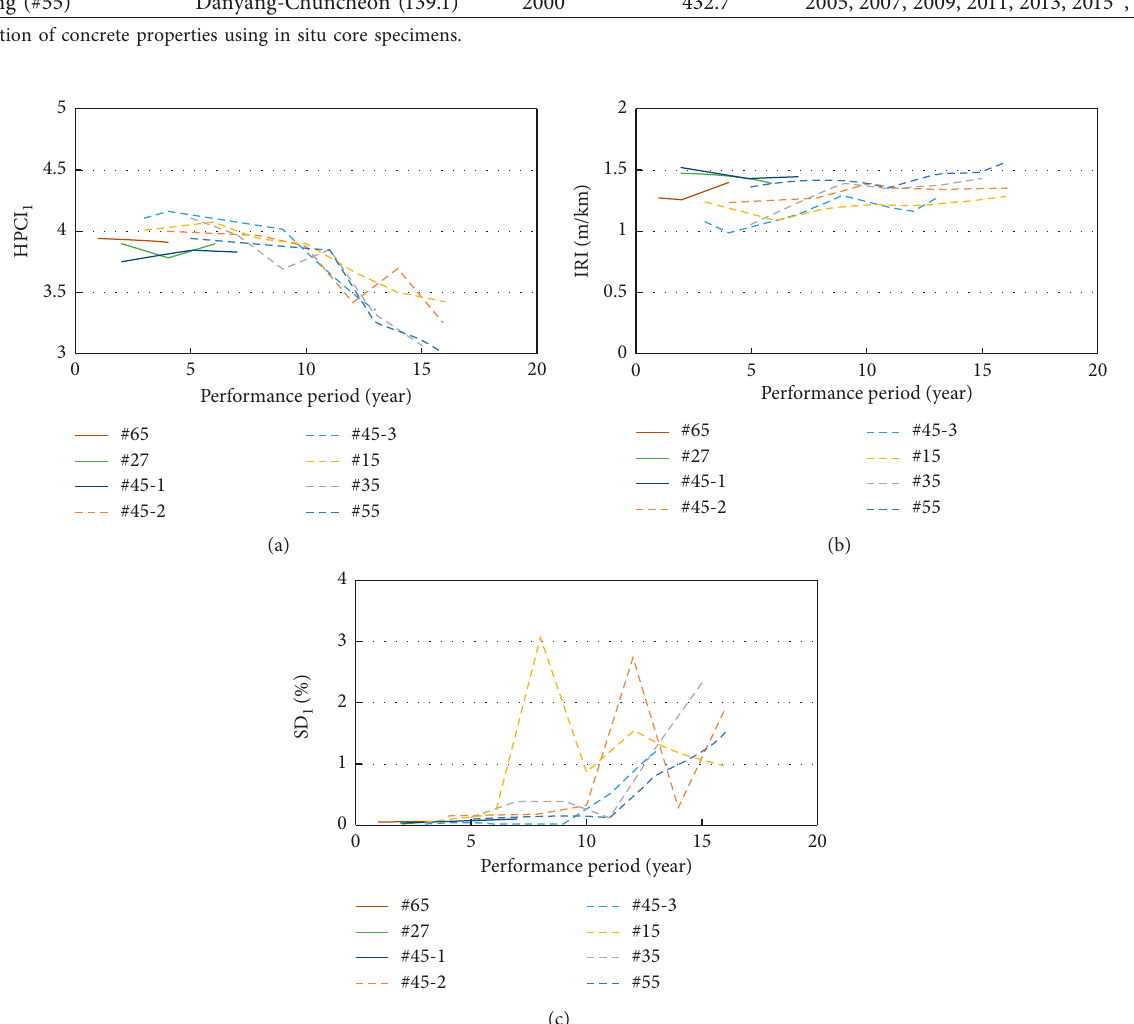
1 . (b) IRI (m/km). (c) SD 1 (%).